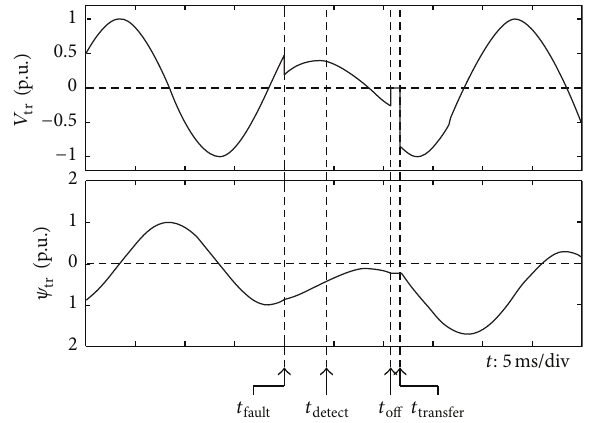
Figure 5: The block diagram of the flux linkage